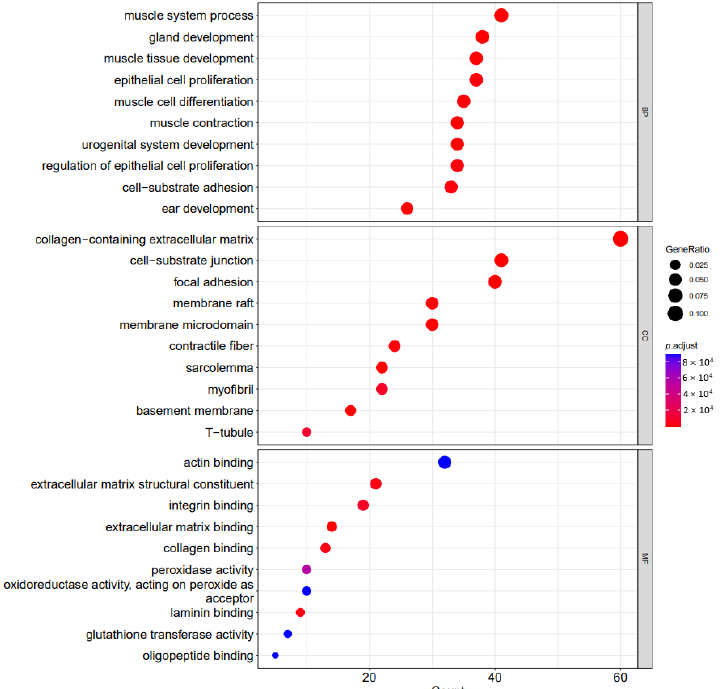
Figure 8. The dot plots of top 10 enriched functions. The gene-set count is shown on the X axis, while the gene-set function is shown on the Y axis. The color of the dot reflects the adjusted p value, and ranges from dark blue (most significant) to red (least significant). GeneRatio is represented by the dot size.